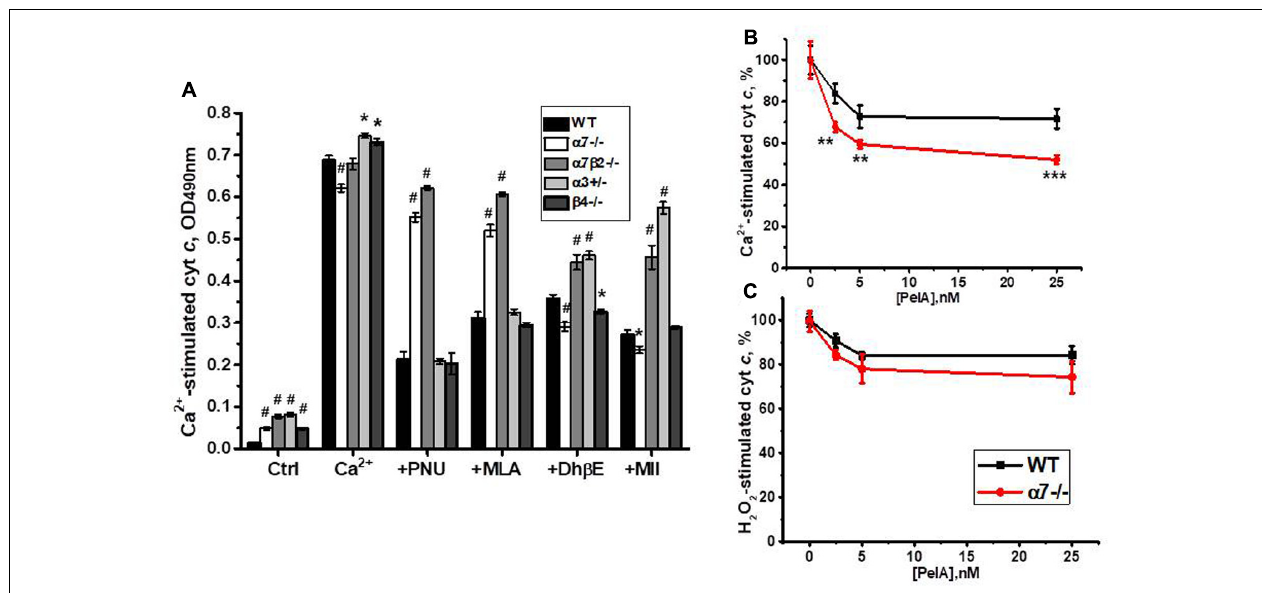
FIGURE 9 | The effect of PNU 282987 (1 µ M), MLA (50 nM), Dh β E (1 µ M), and α -conotoxin MII (1 nM) (A) or α -conotoxin PeIA (B,C) on Ca 2 + (0.9 µ M)-stimulated (A,B) and H 2 O 2 (0.5 mM)-stimulated (C) cyt c release from mitochondria of the wild-type (WT) and knockout mice. Each column (A) or point (B,C) corresponds to mean ± SE, three to five mice per genotype; ∗ p < 0.05; ∗∗ p < 0.005; ∗∗∗ or # p < 0.0005 compared to